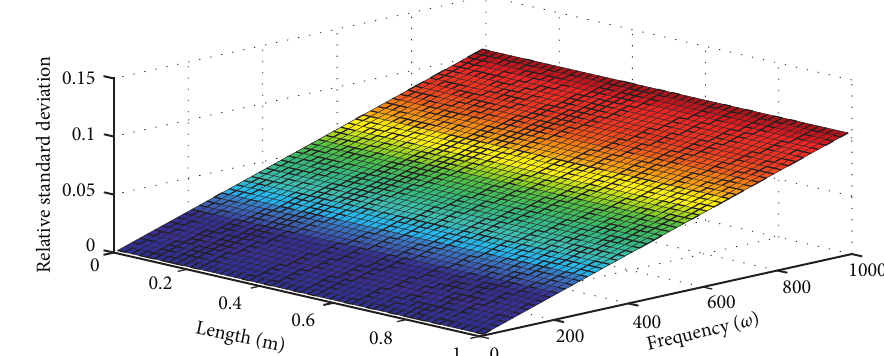
Figure 8: Relative standard deviations of energy densities of the rod.